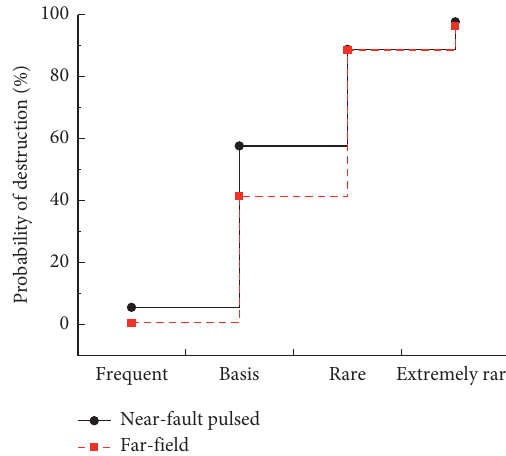
Figure 13: The destruction probability of the tunnel structure under the action of different ground motions: (a) near-fault pulsed; (b)